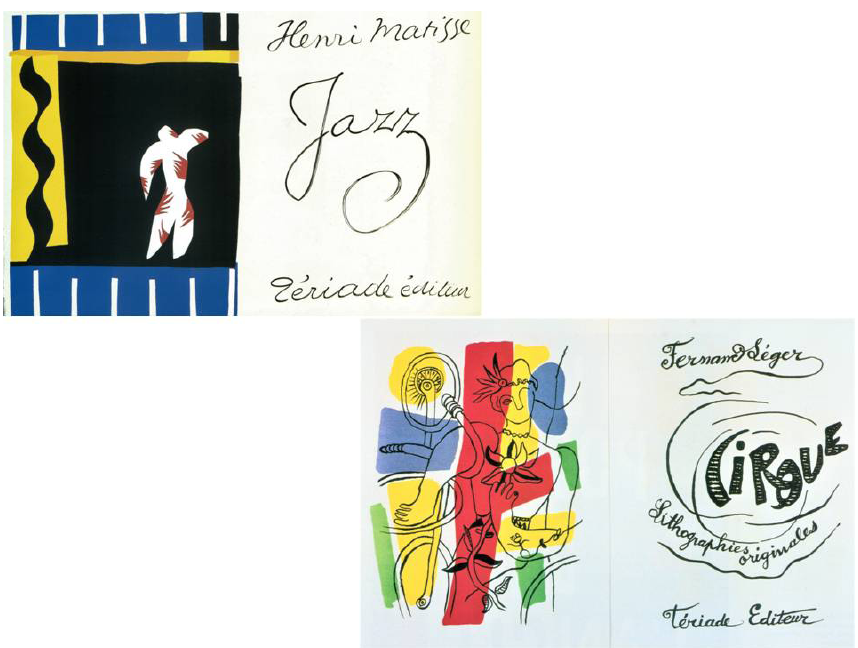
Fig. 7 Frontispices des livres de Henri Matisse, Jazz (1947), et de Fernand Léger, Σ Δ EETE [OSDEETE], Cirque (1950), © ADGP, Paris, O